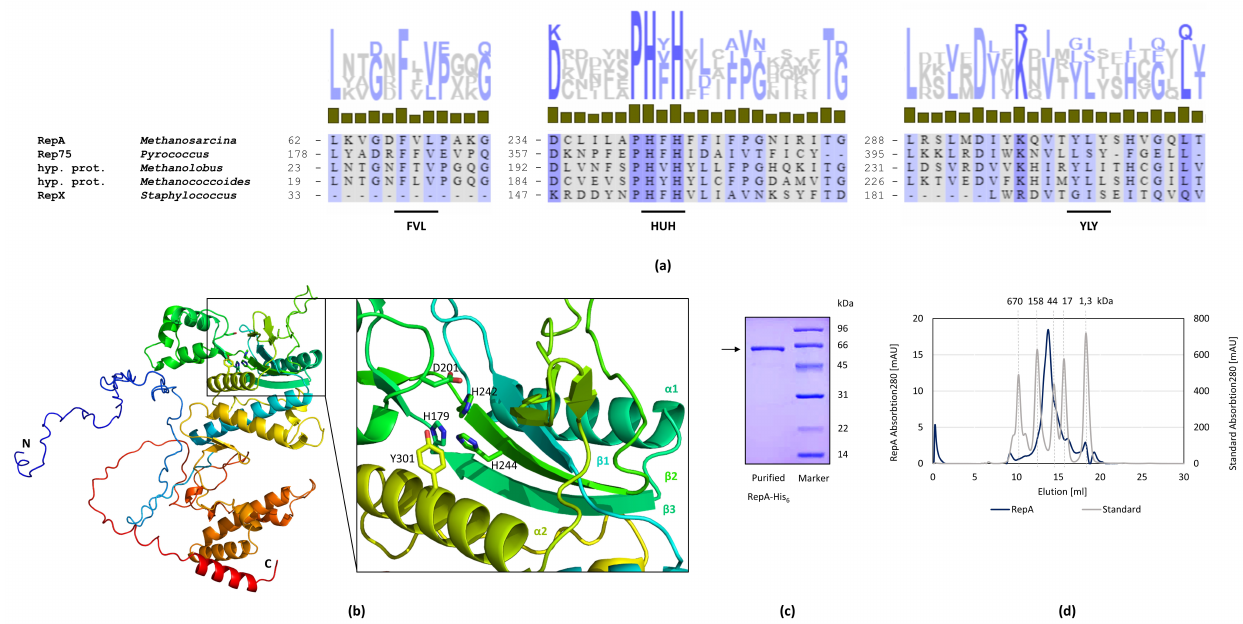
Figure 4. Characterisation of RepA. ( a ) Alignment of the FVL, HUH and YLY motif of putative rep type proteins (indicated with black lines). The amino acid alignment of the archaeal proteins RepA from Methanosarcina acetivorans , Rep75 from Pyrococcus abyssi [16], putative rep type proteins from Methanolobus profundi and Methanococcoides methylutens [22] and the bacterial RepX from Staphylococcus aureus [23] was generated with Clustal Omega and amino acids were shaded after Percentage Identity (grey indicating low PID, blue indicating high PID). The proteins show high similarity in the region of the HUH motif. ( b ) Predicted secondary structure of RepA. The overall structure of RepA is shown as a cartoon model. Each RepA monomer consists of the N-terminal origin-binding domain, carrying an α - β - α sandwich fold with the active centre and the C-terminal domain that is potentially important for oligomerisation. The amino acids proposed to be part of the active centre are shown as sticks including the HUH motif (H242, F243, H244) and YLY motif (Y301). The structure was predicted with AlphaFold2 and visualised using PyMOL. ( c ) Coomassie-stained SDS-PAGE of heterologously expressed and purified His-tagged RepA. RepA was overexpressed in E. coli BL21 (DE3)-Codonplus- RIL containing pRS1559 by induction with 100 µ M IPTG in LB medium for 4 h and purified by Ni-NTA chromatography. The LMW marker from the Amersham LMW Calibration Kit for SDS Electrophoresis was used as ladder. ( d ) Size-exclusion chromatography (SEC) of RepA. SEC revealed that RepA elutes in its monomeric form (64 kDa) in His-tag buffer. The SEC Standard (Bio-Rad, #1511901, MW 1350–670,000) was used as a